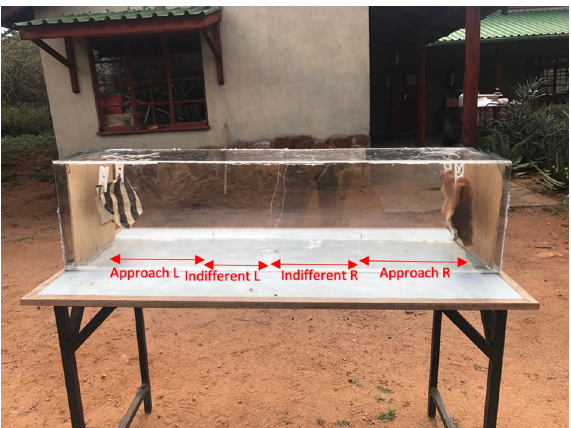
Figure 3. Experimental set-up for a plains zebra vs. impala skin trial. Landings were recorded as having occurred on a skin surface, within the approach zone of 30 cm from the skin, or in the indifferent zone of 30–60 cm from the skin on either side of the petri dish. Photo credit: